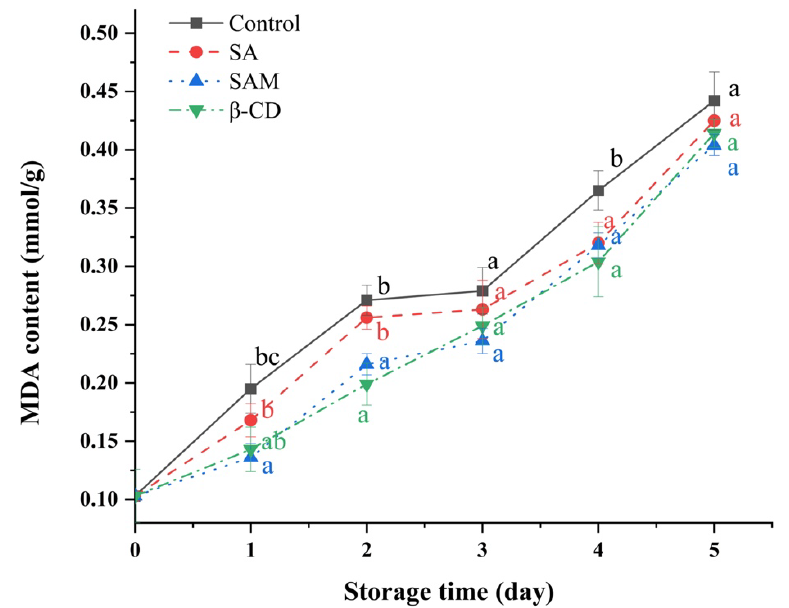
Figure 5. Effect of SAM on malondialdehyde (MDA) contents in ‘Fuji’ apple stored at 25 °C for 5 days. SA, salicylic acid; SAM, salicylic acid microcapsule; β - CD, β -cyclodextrin. Control group was prepared with sterile distilled water. Vertical bars represent standard errors. Different letters within each day show a significant difference ( p < 0.05). Table 1. Effect of SAM on ‘Fuji’ apple firmness during 5 days of storage at 25 ◦